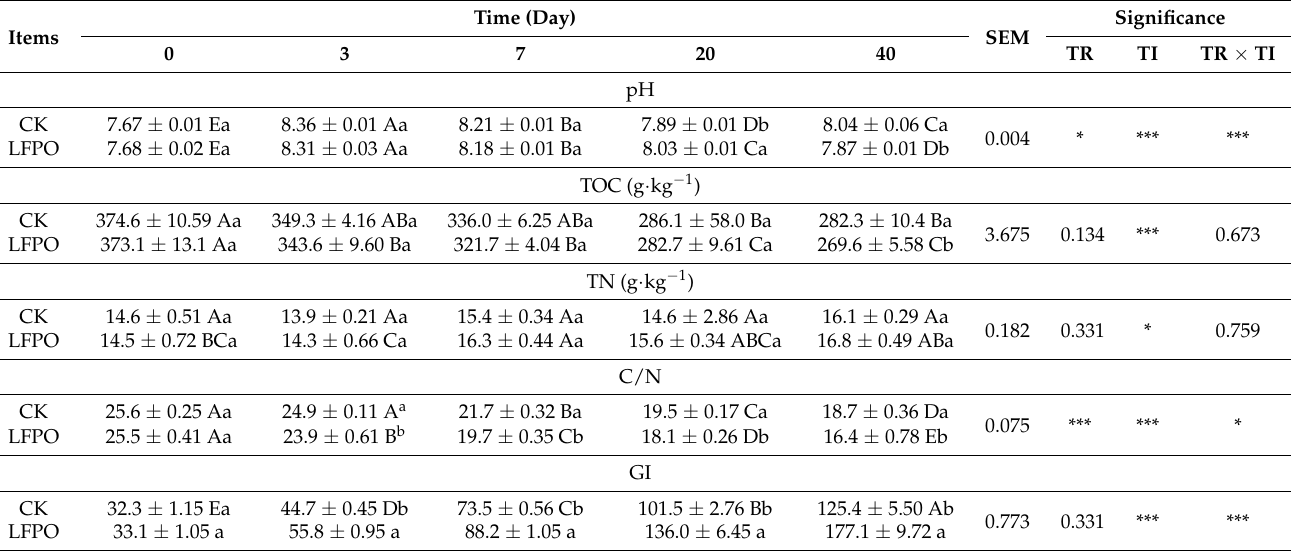
Table 2. Variations in physico-chemical properties during